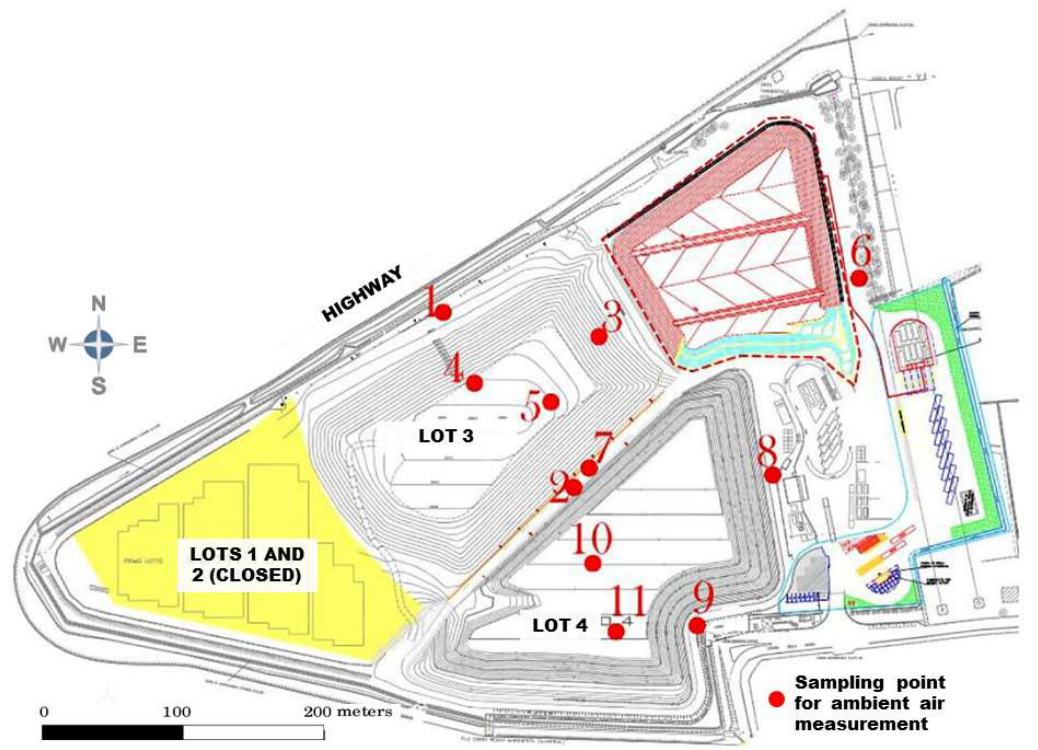
Atmosphere 2020 , 10 , x Figure 4. Location of sampling points for ambient air monitoring. Figure 4. Location of sampling points for ambient air monitoring.